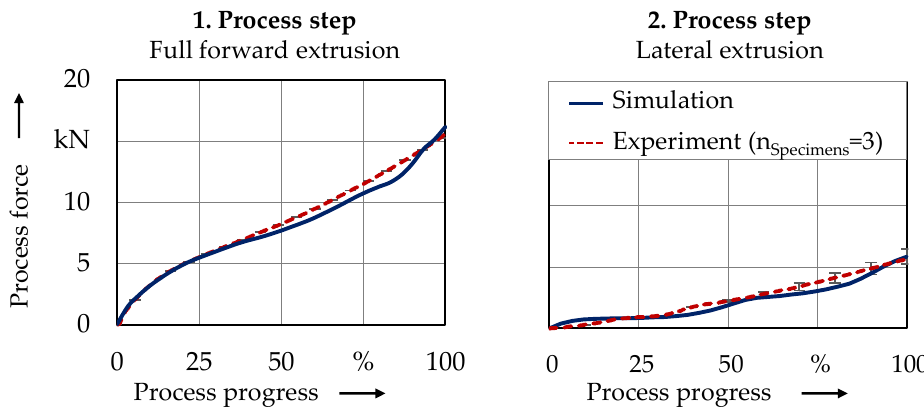
Figure 4. Comparison of force curve progression in simulation and experiment. The process force curves show good agreement. The maximum process forces re- quired for forward extrusion (16.2 kN simulation and 15.6 ± 0.7 kN experiment), as well as for lateral extrusion (7.0 kN simulation and 6.6 ± 0.5 kN experiment) deviate less than 6%. A comparison of the geometric properties is made in Figure 5. Moreover, regarding the die filling, the simulation showed a good agreement.